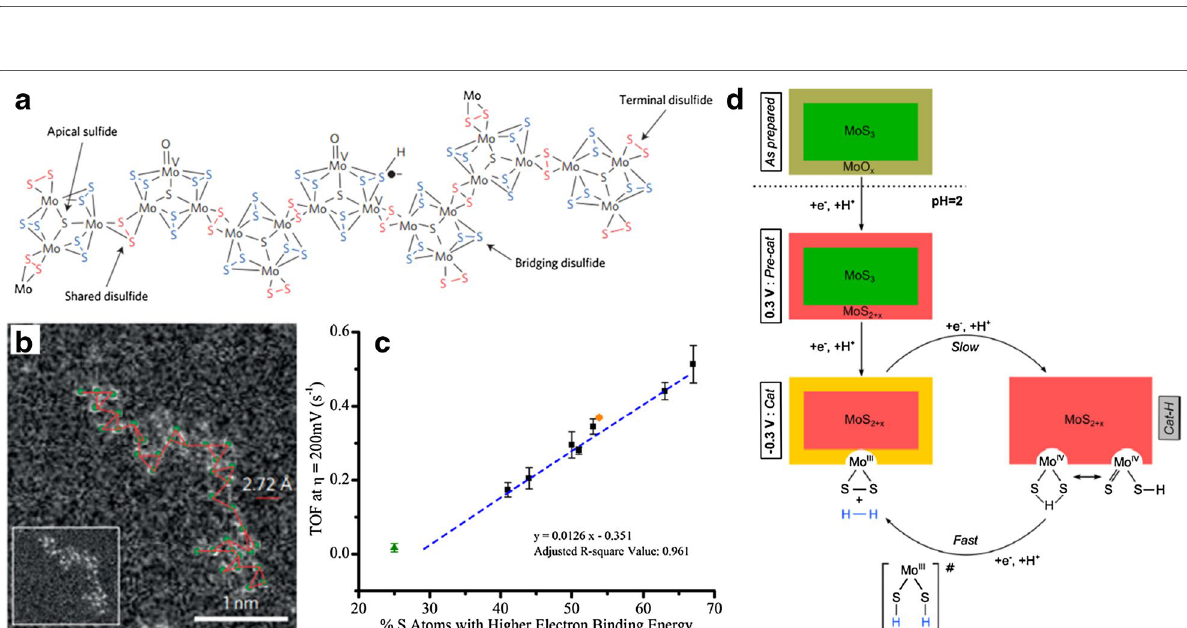
Fig. 5 a Coordination polymeric structure of the amorphous MoS x containing [Mo 3 S 13 ] 2 − building blocks. b Arrangement of the cluster units in a 1D unfolding chain. c TOFs versus the percentage of S atoms with high electron binding energy. d Proposed catalytic cycle for the HER over amor- phous MoS x (Figures reprinted with permission from Refs.